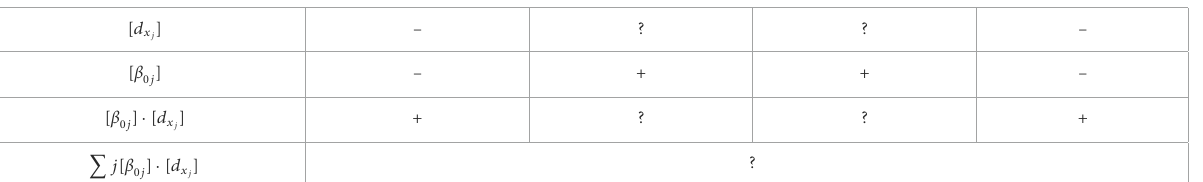
TABLE 1 Qualitative simulation of CV/IV.